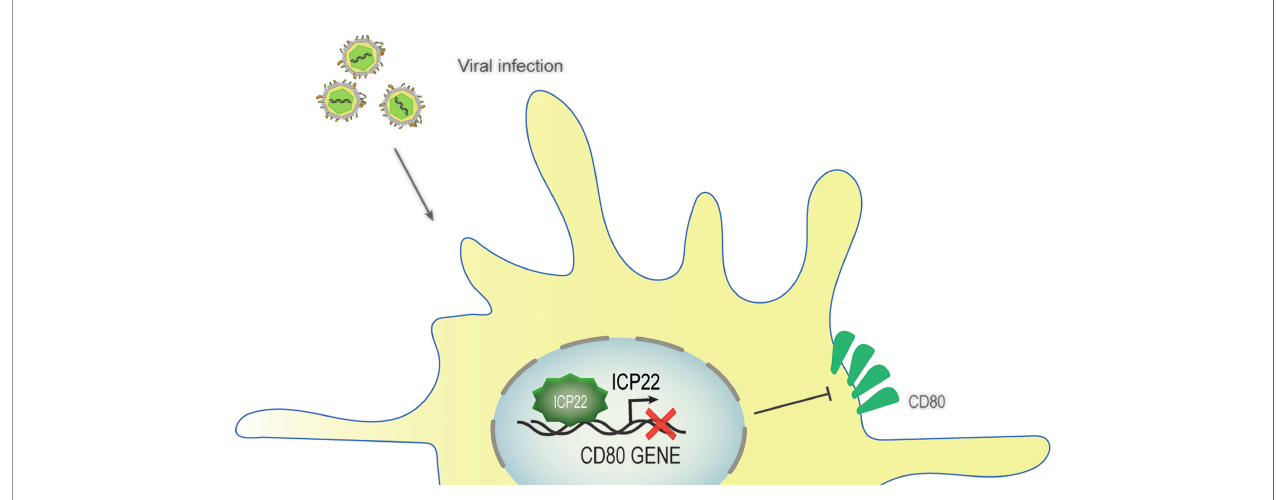
FIGURE 6 | Schematic diagram of HSV-1 ICP22 downregulating CD80 expression. Ocular infection of mice with HSV-1 suppressed the expression of the costimulatory molecule CD80. HSV-1 ICP22 downregulates the expression of CD80 by speci fi cally binding to the CD80